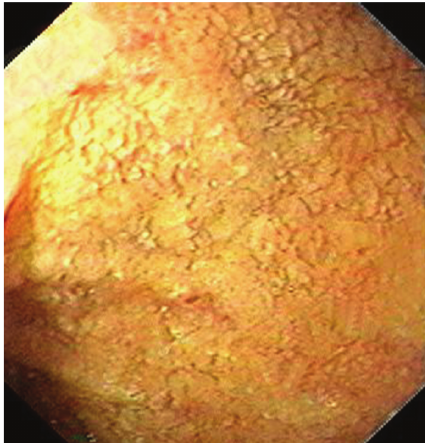
Figure 9: Whipple’s disease: no folds are seen in the jejunum. Surface of mucosa is irregular; there are several tiny haemorrhages in mucosa with an appearance like being dusted with flour.